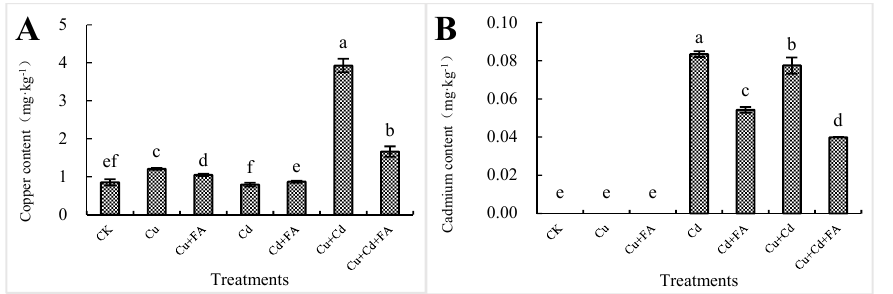
Figure 3. Effects of spraying FA on Cu, Cd in tomato fruit under different Cu ( A ), Cd ( B ) stress . The same alphabet above each column shows no significance ( p > 0.05), in contrast, having significance ( p < 0.05).